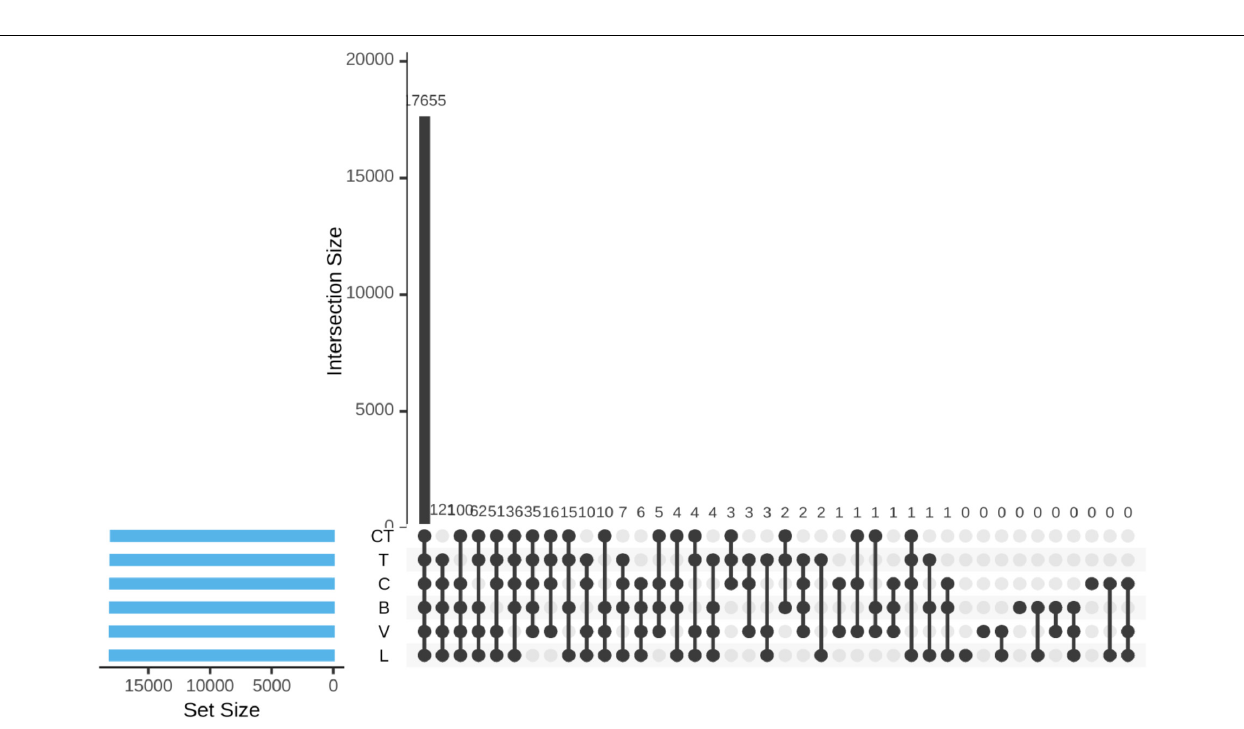
FIGURE 2 | UpSet diagram visualizing intersections of sets of OTUs between different